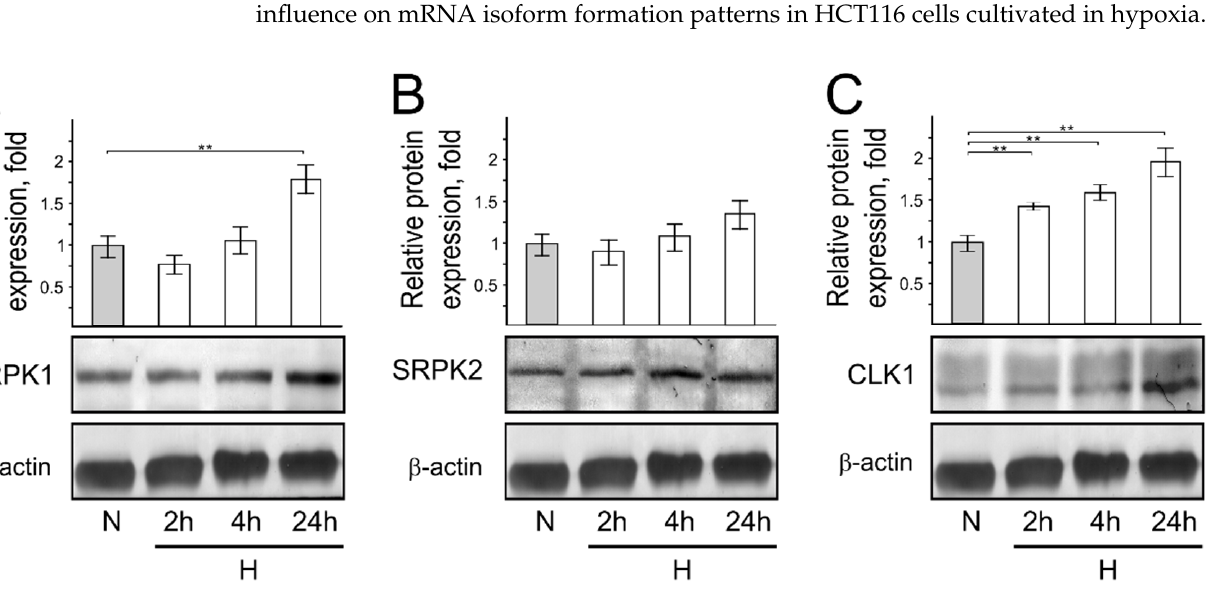
Figure 6. Protein phosphatase PP1 and PP2A protein expression in normoxic and hypoxic HCT116 cells. Western blot showing PP1 ( A ) and PP2A ( B ) protein expression levels in normoxic and hy- poxic cells. Bar plot represents the quantification of endogenous protein expression of 3 inde- pendent experiments when protein expression in cells grown under normal oxygen conditions is taken as 1. Error bars represent the amount of spread between the extremes of the data, ** p < 0.05; * p < 0.01. N—cells cultivated under normal conditions; H—cells cultivated under hypoxic condi- tions for indicated time (2 h, 4 h, and 24 h).